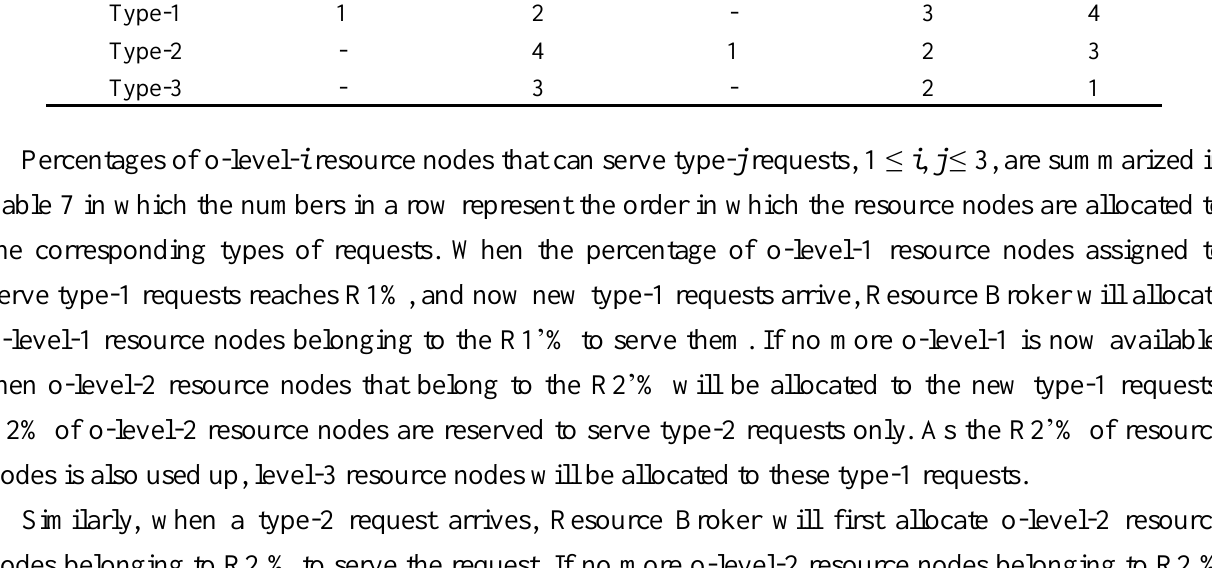
Table 7. The percentages of o-level- i resource nodes that can serve type- j requests, 1 ≤ i , j ≤ 3. O-level-1 O-level-1 O-level-2 O-level-2 Level-3 Nodes resource nodes resource nodes resource nodes resource nodes resource of R1 % of R1’% of R2% of R2’% nodes Type-1 1 2 - 3 4 Type-2